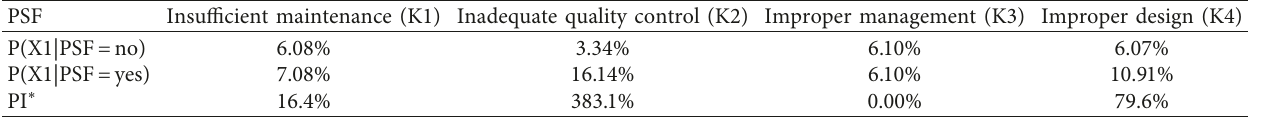
Figure 2: Parameter estimation for CPT (partial BN). Table 1: Influence (probability increase) of root nodes on unsafe